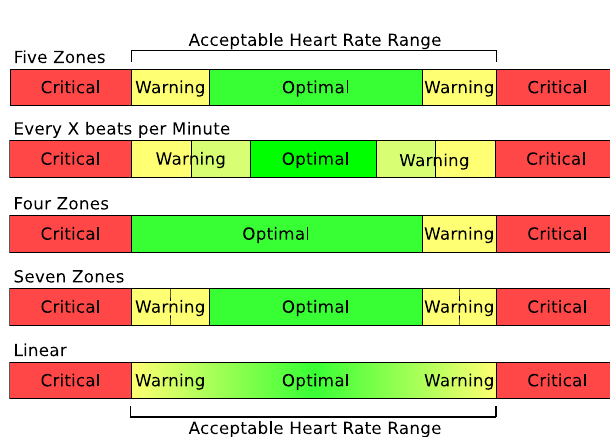
Figure 2. Overviewof the di˙erentdesign types